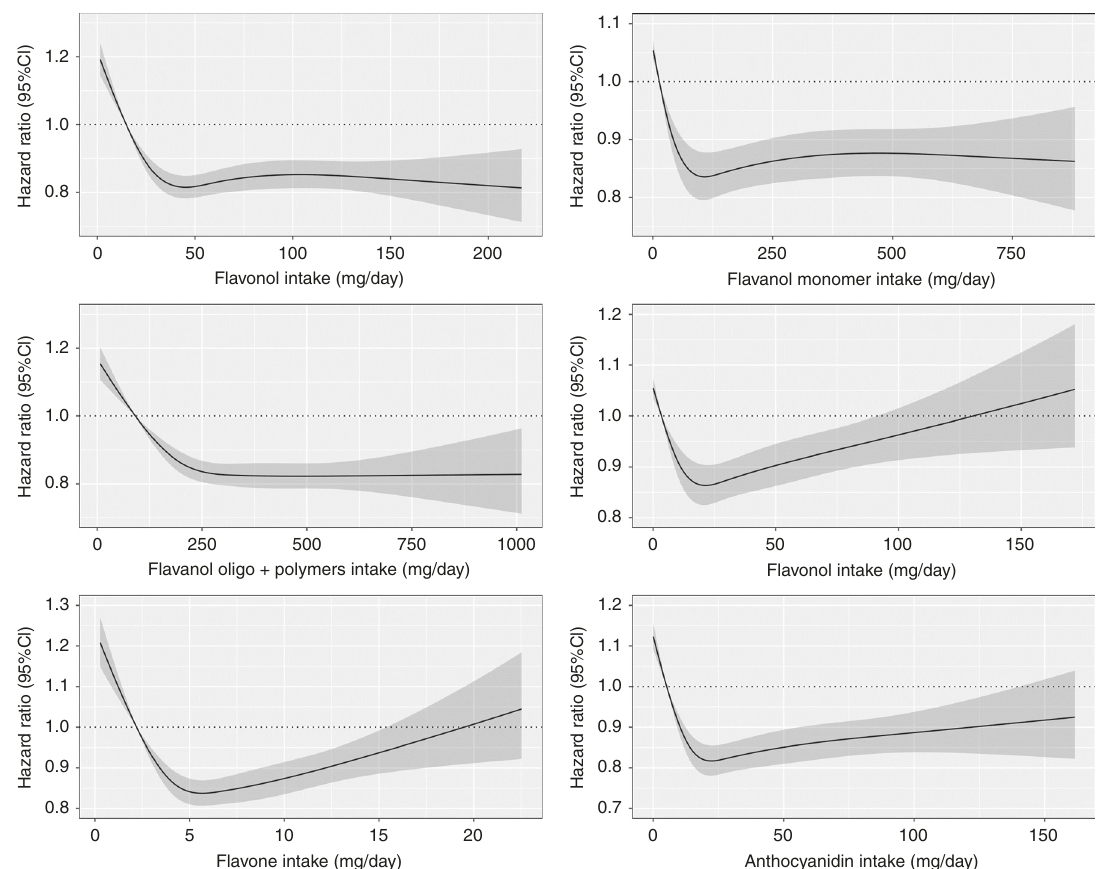
Fig. 2 The association between fl avonoid subclass intakes and all-cause mortality. Hazard ratios are based on Cox proportional hazards models adjusted for age, sex, BMI, smoking status, physical activity, alcohol intake, hypertension, hypercholesterolemia, social economic status (income), and prevalent disease and are comparing the speci fi c level of fl avonoid intake (horizontal axis) to the median intake for participants in the lowest intake